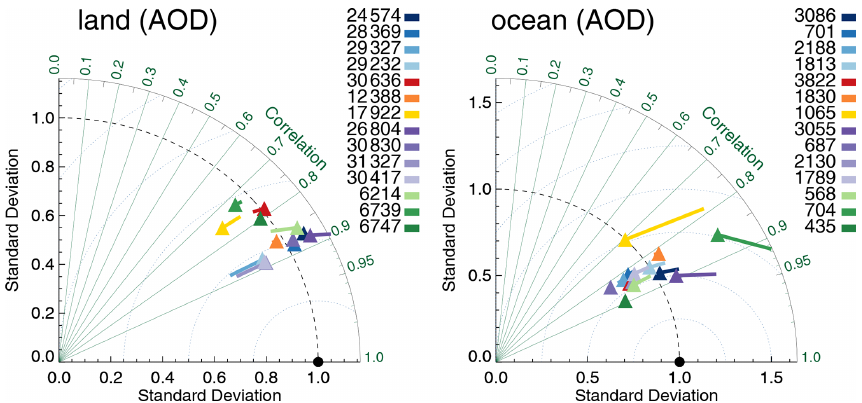
Figure 3. Taylor diagram for satellite products evaluated over either land or ocean with AERONET. Symbols indicate correlation and internal variability relative to AERONET; the line extending from the symbol indicates the (normalized) bias (see also Sect. 3.1). Colours indicate the satellite product (see also Fig. 1); numbers next to coloured blocks indicate the amount of collocated data. Products were individually collocated with AERONET (Kinne et al., 2013, selection, pruned) within 1h.